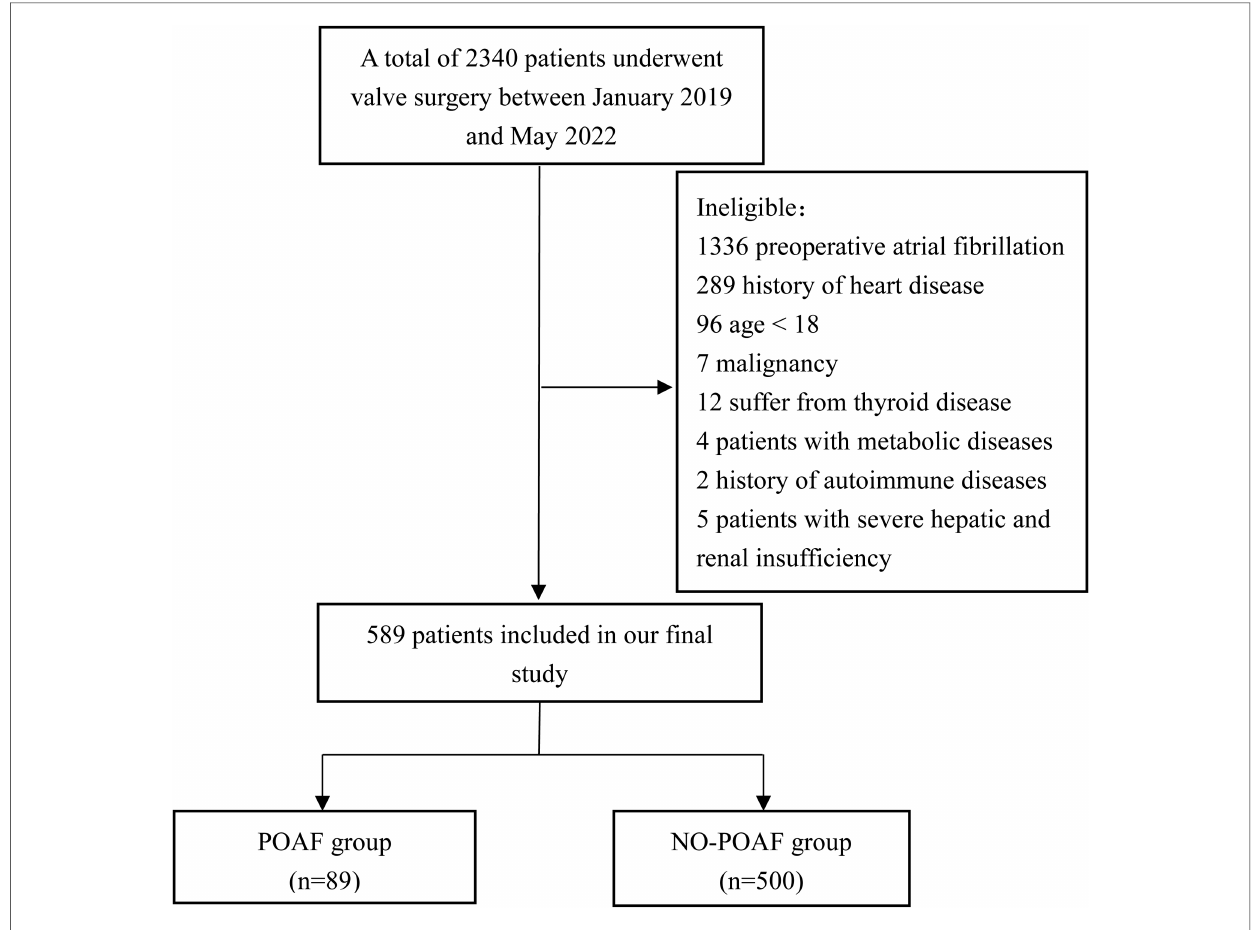
FIGURE 1 Patienst inclusion fl ow chart.